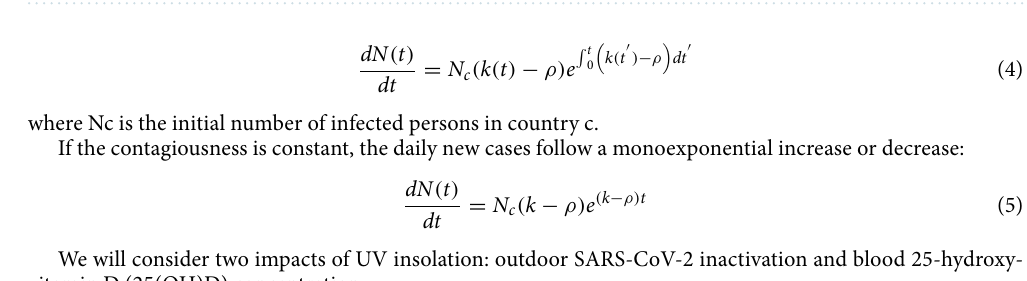
Figure 2. (A) Survival of the active SARS-CoV-2 fraction after 30 min of solar UV insolation as a function of τ 90 . (B) Solid black line: acute respiratory track infection (ARTI) risk during cold and influenza epidemics as a function of the 25(OH)D concentration (reprinted from 3 according to the CC BY 4.0 licence terms (https ://creat iveco mmons .org/licen ses/by/4.0/); red and blue curves: power exponential (Eq. 8) and first point monoexponential fits added by the present author. In both graphs, the corresponding date runs from left to right. (C,D) Blue curve: corresponding new daily cases to (A,B) obtained by numerically integrating Eq. (4) (see excel file). In both integrations, k 0 was fitted to obtain a typical threefold increase in the last 10 days (see Fig. 1), and ρ was neglected (surge phase). Black curve: mono-exponential